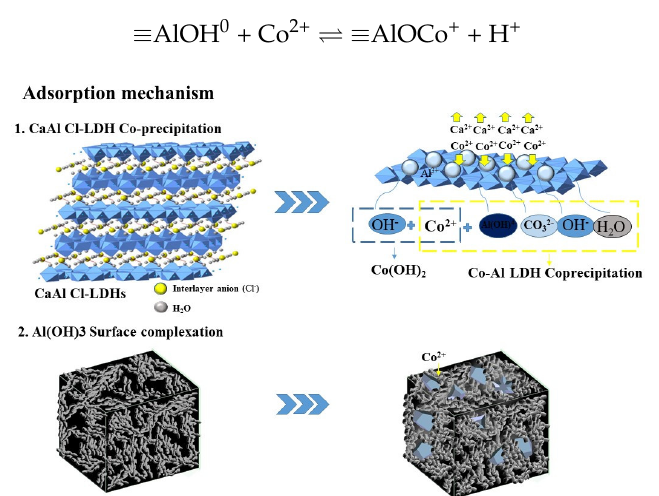
Figure 7. Scheme representing the Co(II) adsorption/absorption mechanisms of CaAl‐Cl‐LDH.